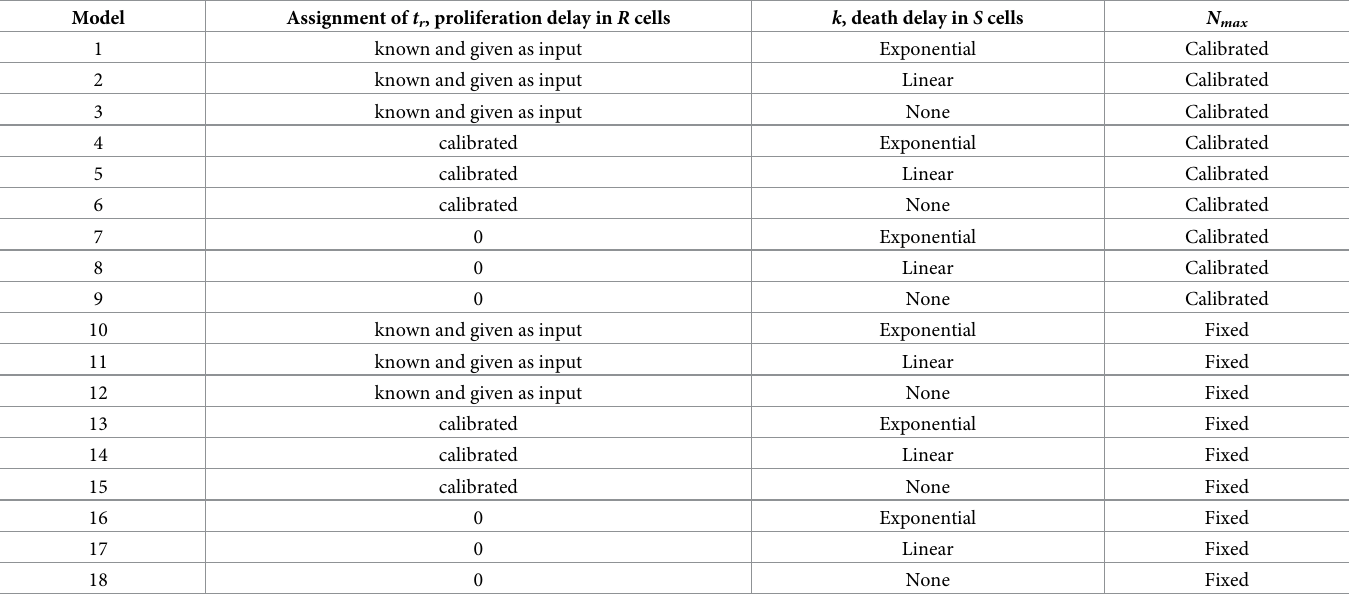
Table 4. Summary of model assumptions tested in model identifiability analysis.